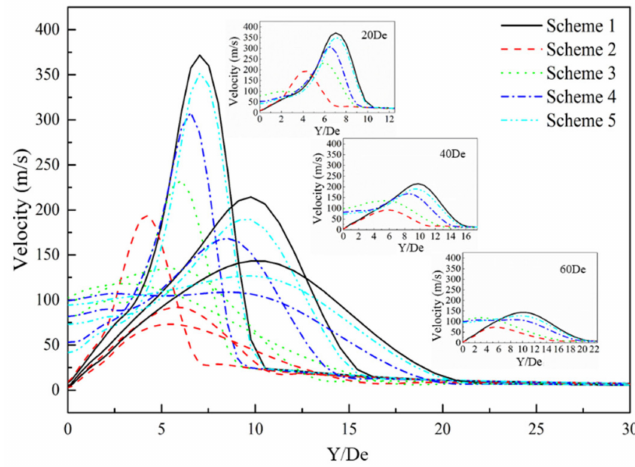
Figure 10. Radial velocity distribution of the supersonic jet of the lance tip.